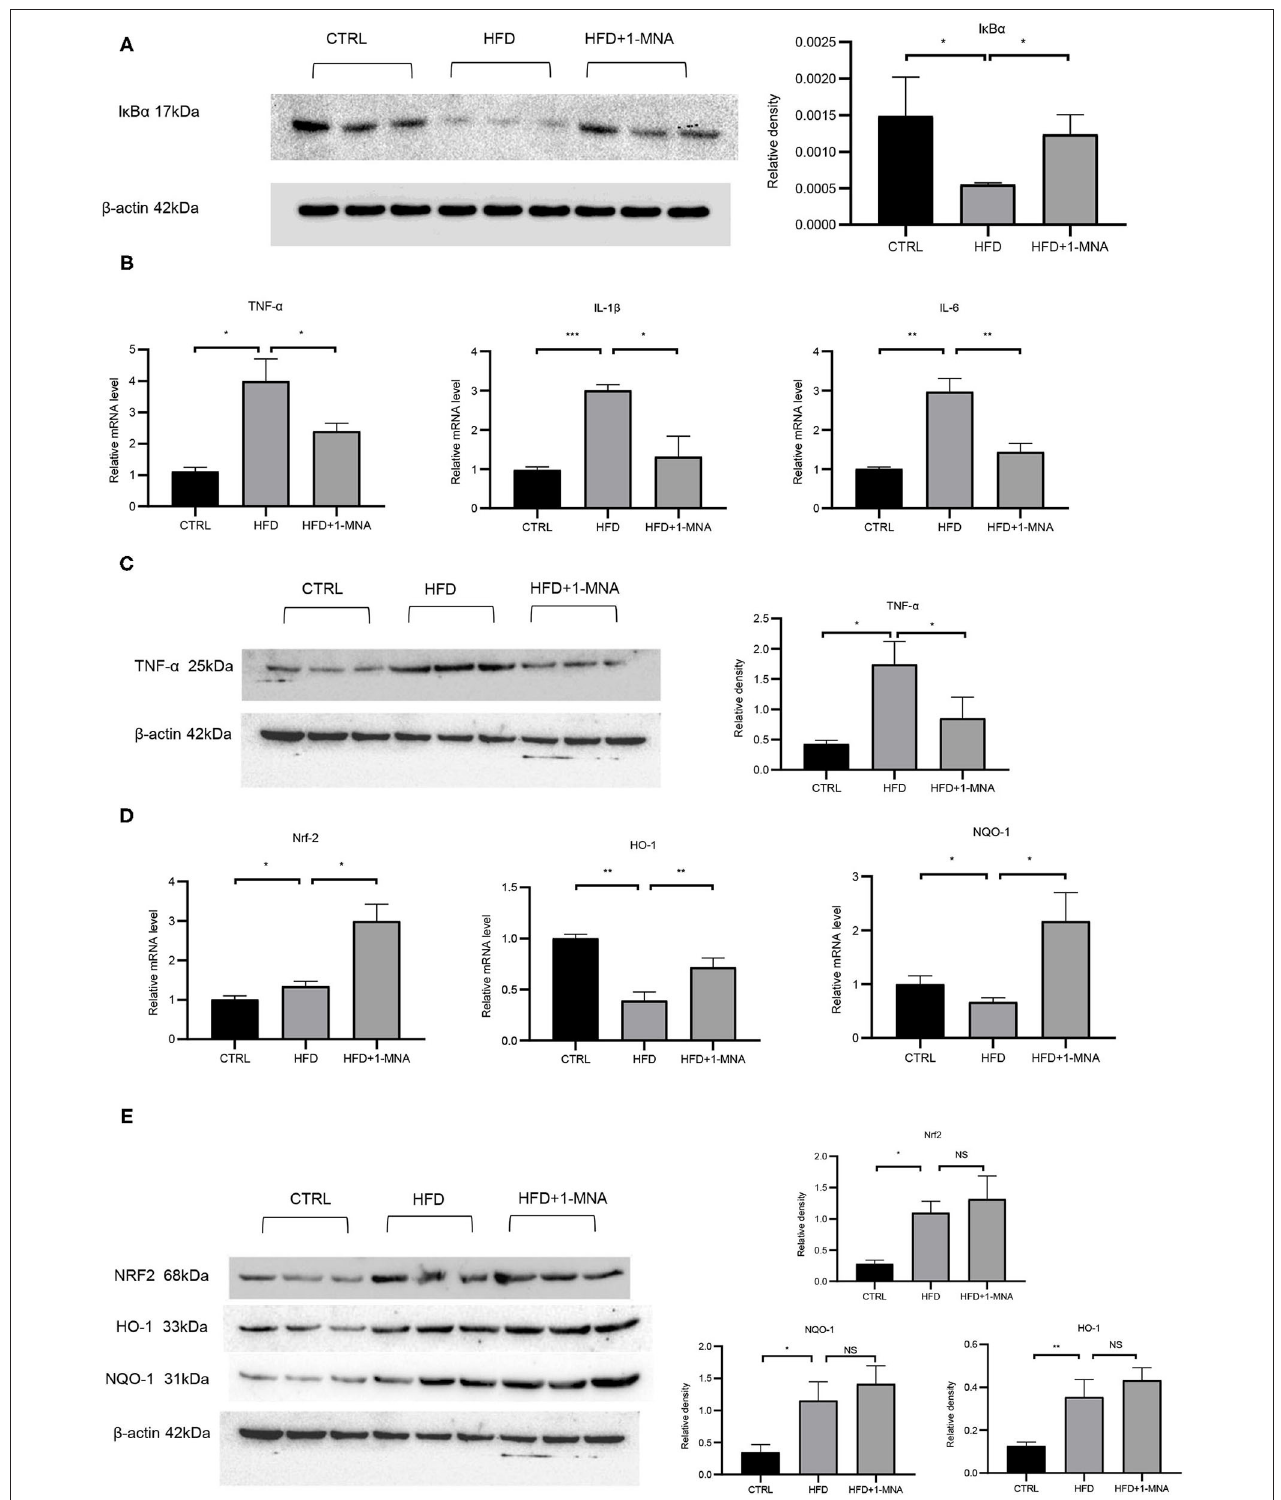
FIGURE 6 | 1-MNA administration improved the oxidative stress and inflammation of the heart induced by HFD. (A) Western blotting analysis of I κ B expression. Quantification of protein expression shown is normalized to β -actin. (B) qRT-PCR analysis of oxidative stress related gene expression. (C) Western blotting analysis of TNF- α . β -actin was taken as an internal control gene. (D) qRT-PCR analysis of inflammation related gene expression. (E) Western blotting analysis of NRF2, HO-1, and NQO-1. β -actin was taken as an internal control gene. ( n = 3, NS = no significance, * P < 0.05, ** P < 0.01, *** P < 0.001).